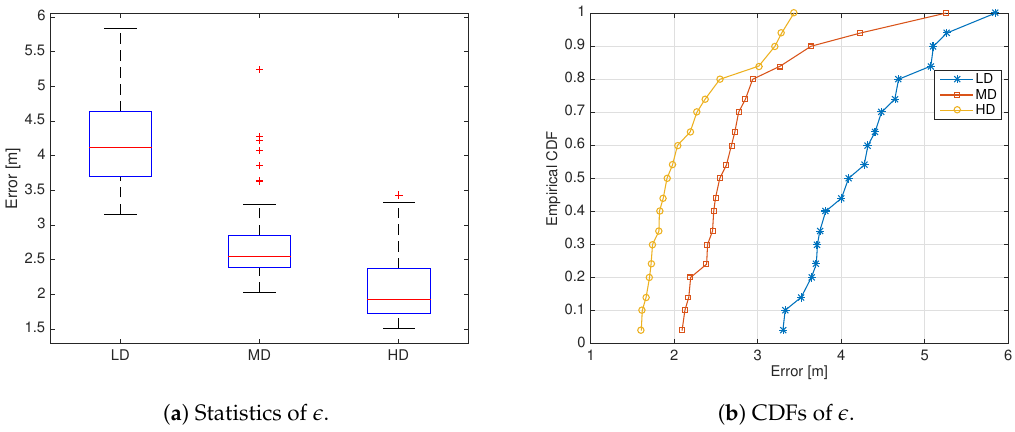
Figure 8. Statistics ( a ) and cumulative density functions (CDFs) ( b ) of the positioning error (cid:101) in low, medium and high density (LD, MD and HD) scenarios for the ultra-wideband (UWB)-combo